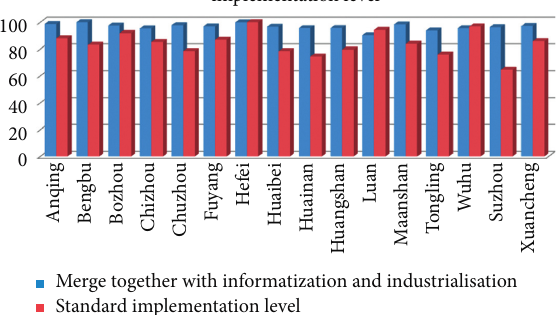
Figure 9: Merge together with informatization and industriali- zation, standard implementation level.